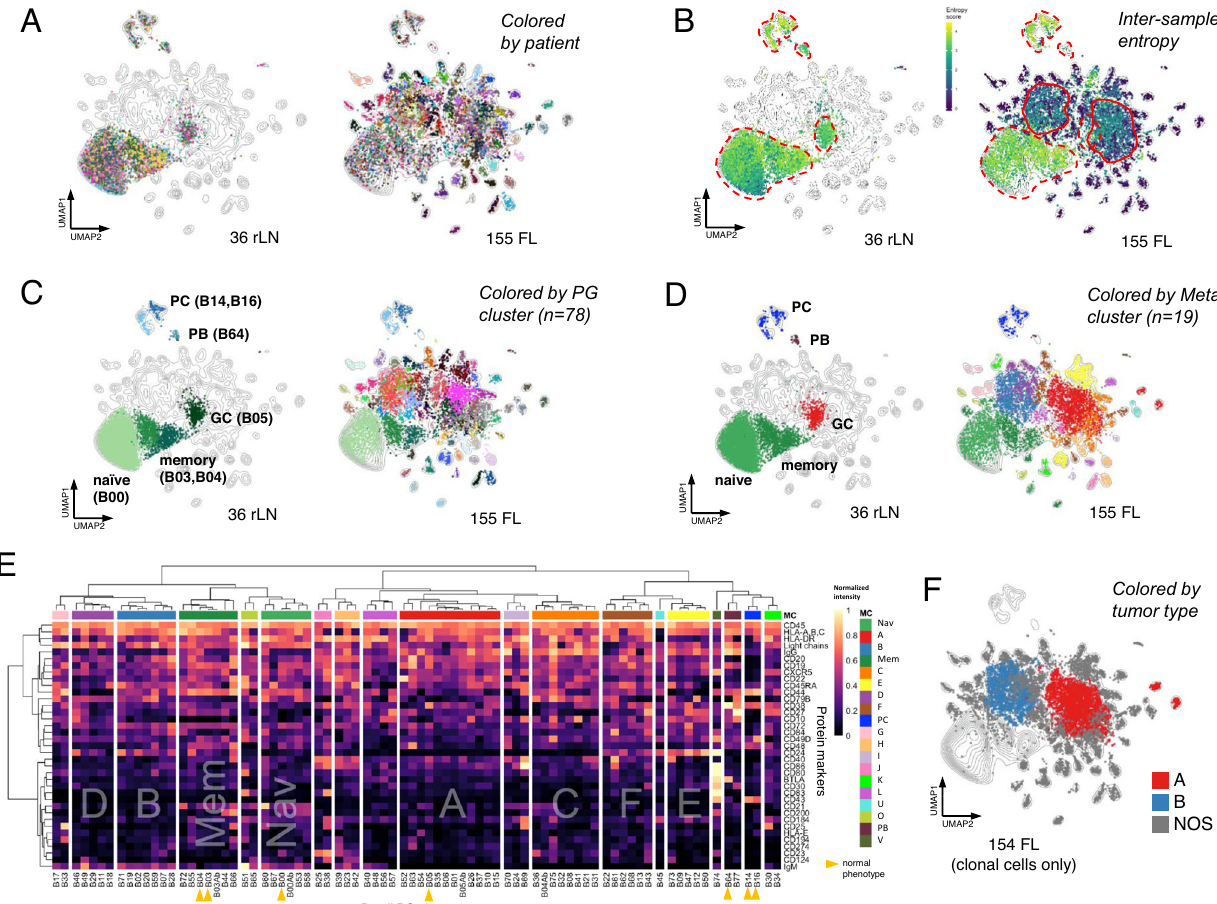
Fig. 1 | Highly dimensional single-cell phenotyping reveals both variable and recurrent phenotypes in FL. A Dimensional reduction UMAP plots of B-cell data from combined analysis of 36 rLN+155 FL patient samples. Each dot represents a singlecell.Dotsarecoloredbypatientsample.EqualnumbersofcellsfromrLNand FL groups were randomly sampled for display. Contour lines show density in the combineddataset. B UMAP plots as in ( A ) but with cellscolored by Shannon index torevealmixingofcellsfromdifferentpatients(intertumoralentropy).Brokenred lines highlight regions co-occupied by rLN cells. Solid red lines highlight two regions of high entropy unique to FL samples. C UMAP plots as in A but with cells colored according to their assigned PhenoGraph (PG) cluster. Normal B-cell populations in rLN samples were manually annotated based on expression of